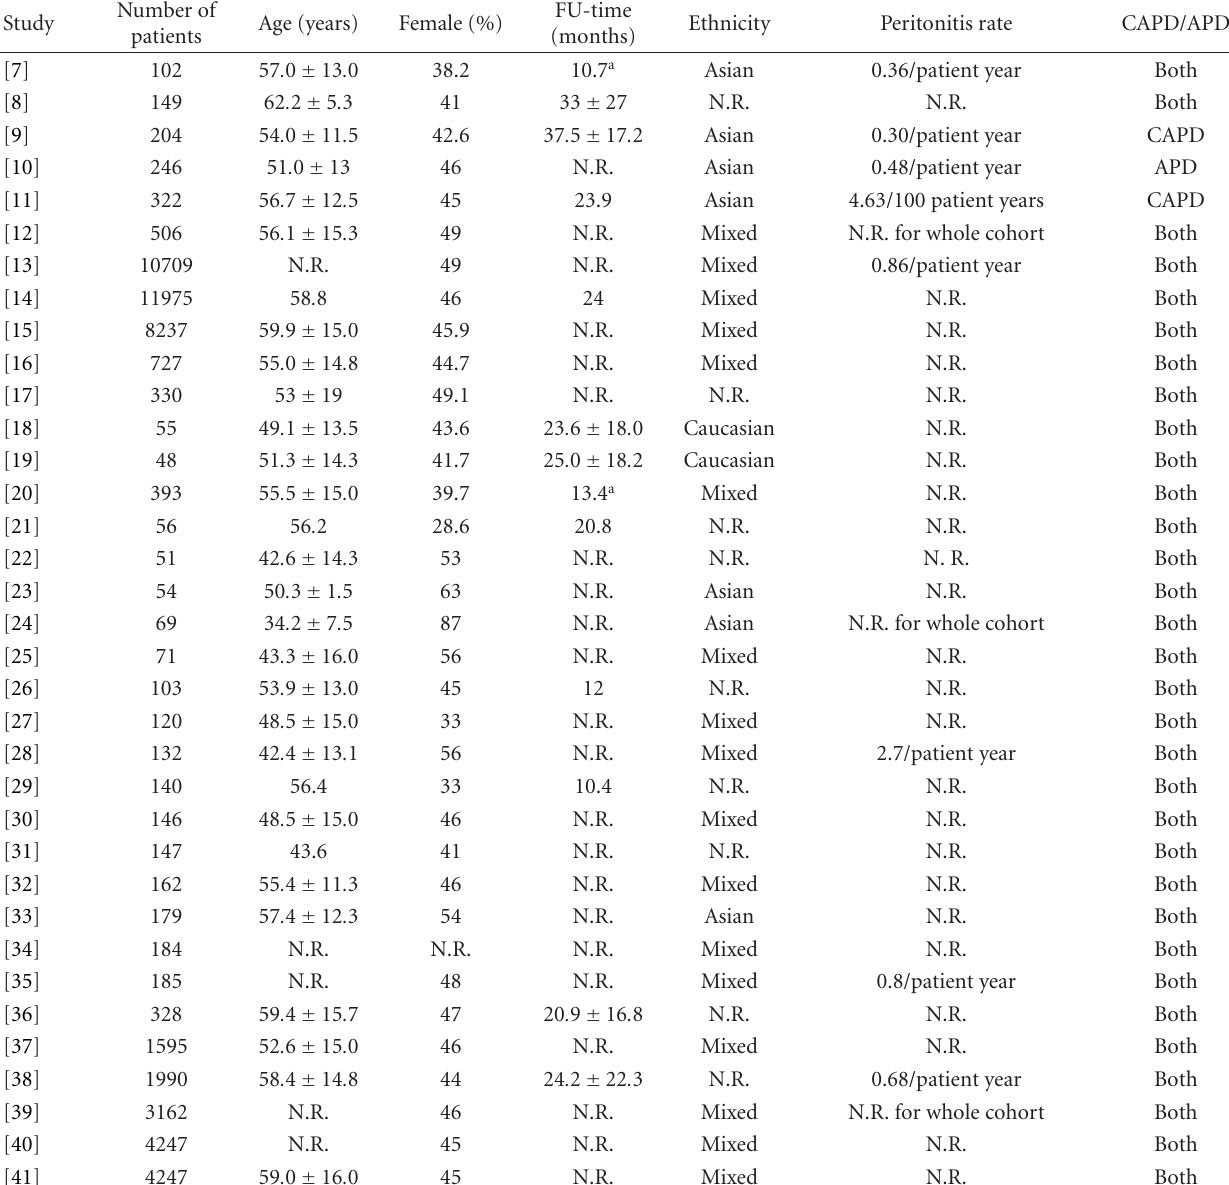
Table 2: Characteristics of identified studies on patient-based risk factors for PD-associated peritonitis. Number of Study Age (years) Female (%) patients